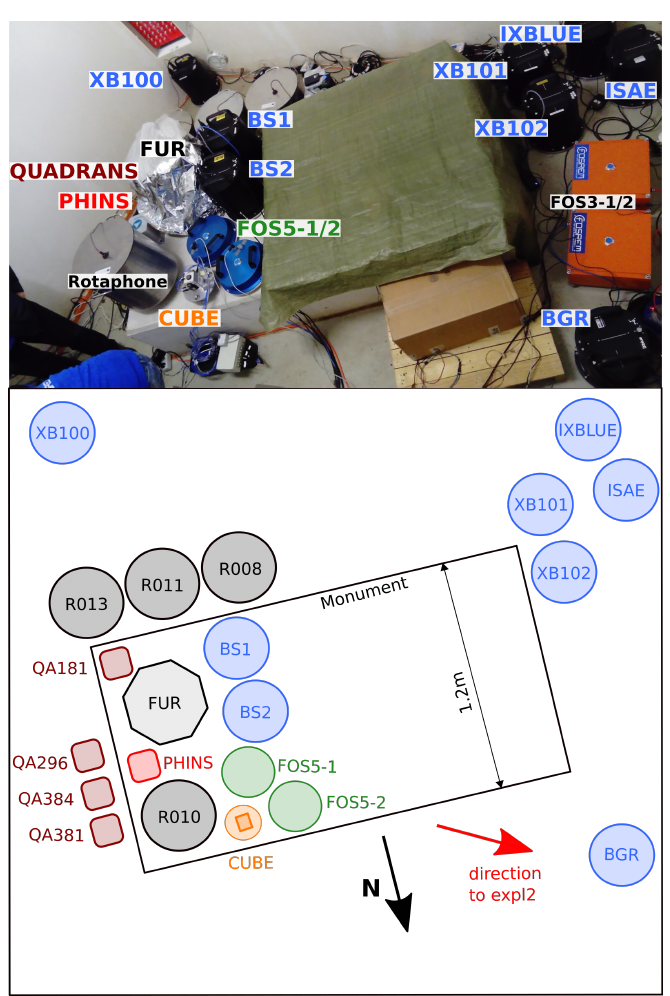
Figure 2. The huddle test took place in the seismic bunker of the German Regional Seismic Network station FUR. The lower panel shows a schematic overview of the huddle test